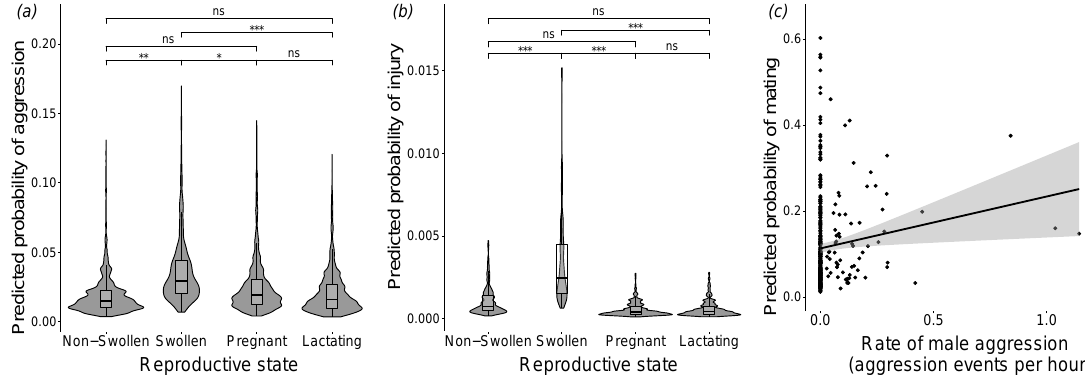
Figure 1 – Results of the tests of the three predictions of the sexual coercion hypothesis. (a) Predicted probability of male aggression received by females as a function of their reproductive state. (b) Predicted probability for females to get injured as a function of their reproductive state. (c) Predicted probability of copulation of a heterosexual dyad as a function of male aggression rate (number of events per hour) received by the female before her swollen period. The fitted values of the GLMMs are shown on the y-axes. In a and b, the violin plots show the predicted probabilities while pairwise comparisons across female reproductive states with corresponding p-values are shown. ‘ns’: not significant (p>0.05); *: p<0.05; **: p< 0.01; ***: p<0.001. In c, for graphical purposes, the regression line is simple linear fit and the shaded area shows the 95% confidence